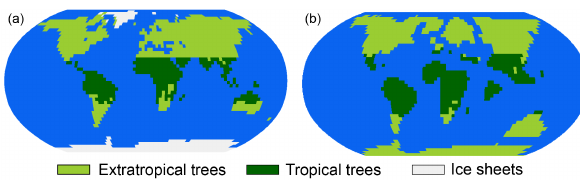
Table 2. Simulations performed with boundary conditions for the early Eocene climate and the pre-industrial climate. The listed veg- etation cover is prescribed on all ice-free continents. The values for the land surface albedo refer to snow-free regions. In the desert world, the surface albedo equals the soil albedo. In the forest world, trees cover the soil completely and the albedo of the forests deter- mines land surface albedo. Figure 2. Vegetation cover in the forest world for the pre-industrial Vegetation Land climate (a) and the early Eocene climate (b) . Extra-tropical trees surface and tropical trees differ concerning their LAI and roughness albedo Dark desert world none 0.1 Bright desert world none 0.4 Forest world 100% tree cover 0.12